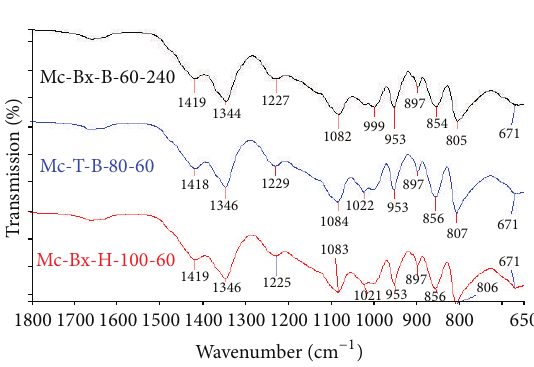
Figure 3: FT-IR spectra of pure admontite minerals.